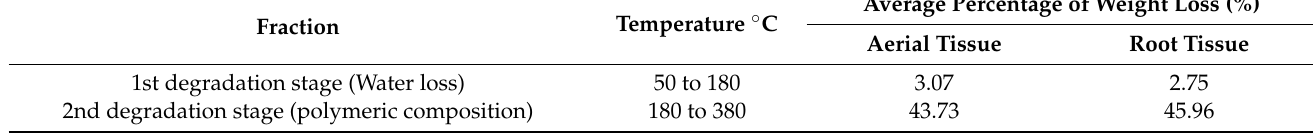
Table 1. Percentage of the mass loss determination from D. antarctica by thermogravimetric analysis (TGA).